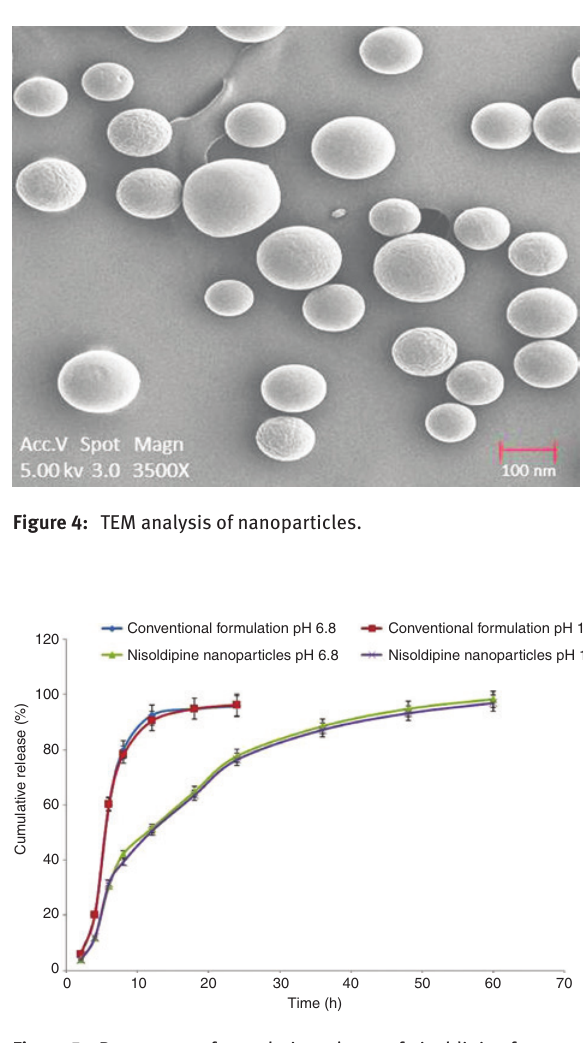
Figure 5: Percentage of cumulative release of nisoldipine from conventional and nanoparticles.